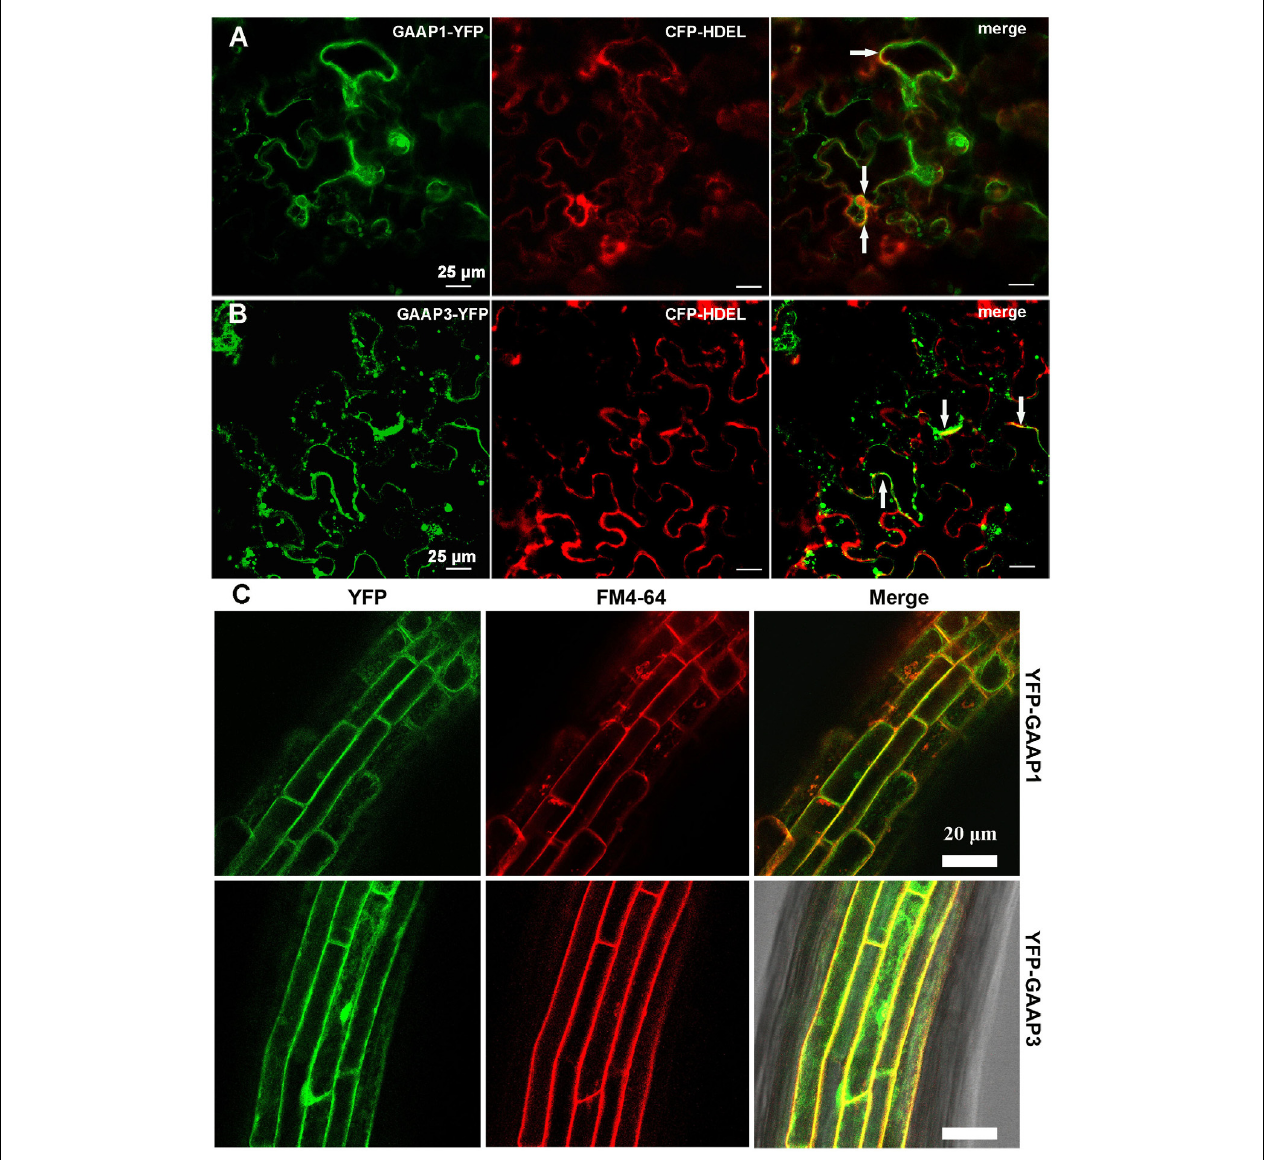
FIGURE 1 | GAAP1 and GAAP3 are located on cellular membrane including the ER.Observation of the fluorescence of GAAP1-YFP (A) and GAAP3-YFP (B) co-transformed with ER marker CFP-HDEL in tobacco leaf epidermal cells. Yellow signals represent co-localization of two proteins, which are pointed by arrows. (C) Fluorescence of YFP-GAAP1/GAAP3 merged with the membrane marker FM4-64 in the root cells of stable Arabidopsis